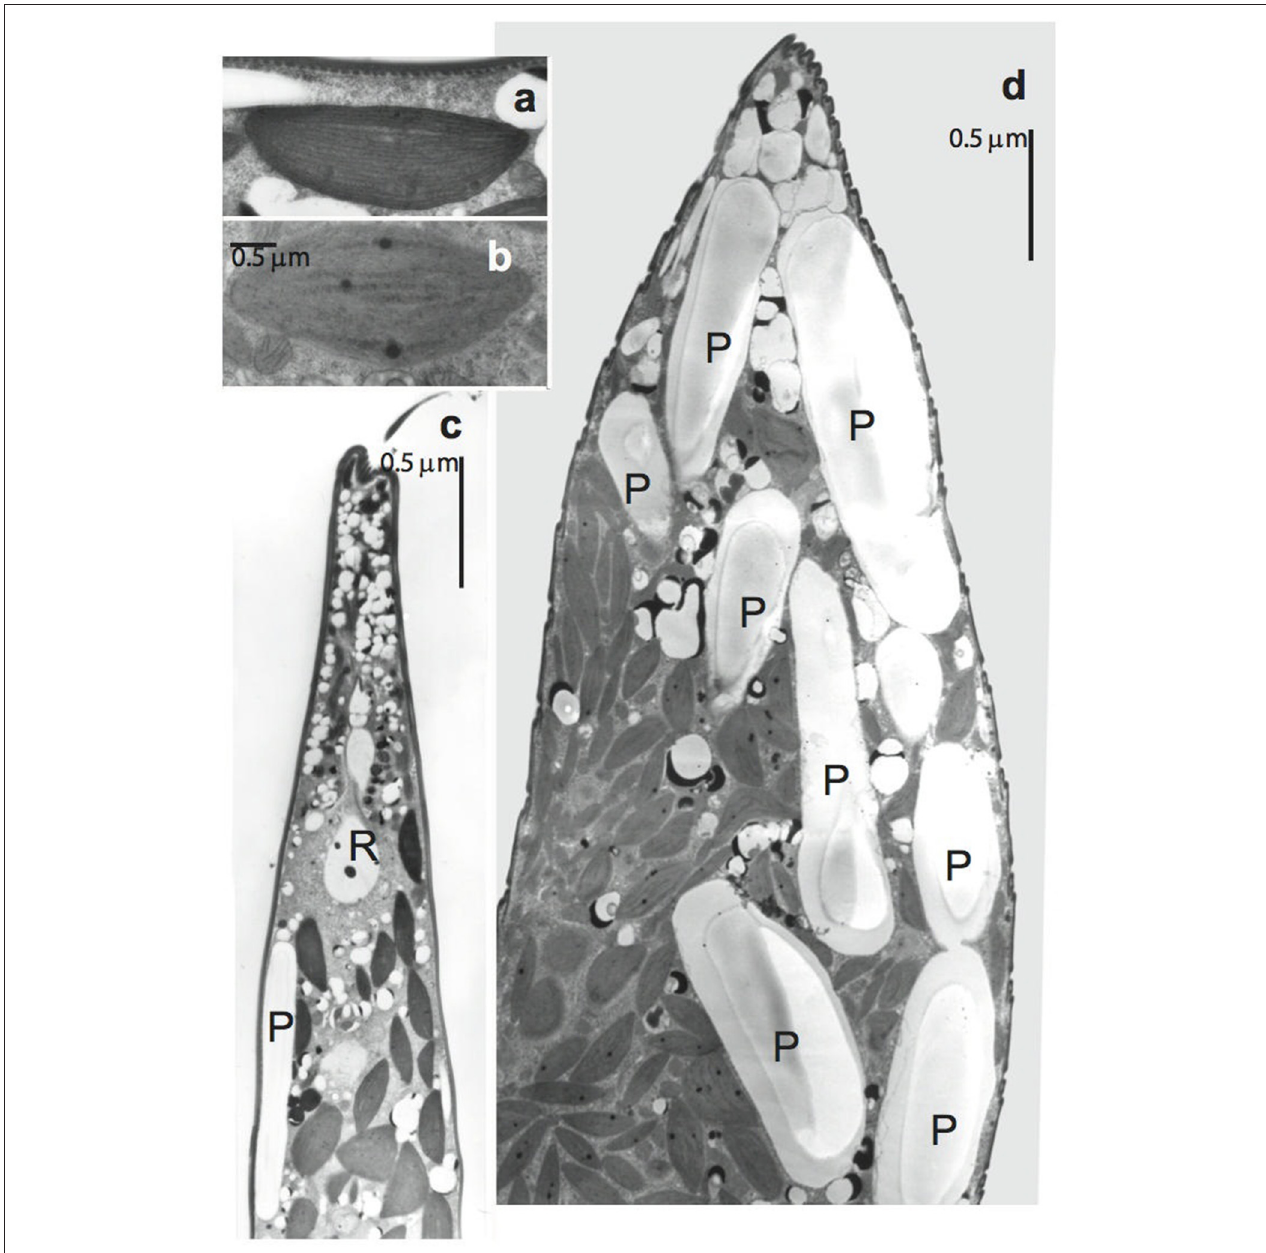
FIGURE 3 | Transmission electron micrographs of Lepocinclis acus . (a,b) Details of chloroplasts. (a) Control cell. (b) Treated cell showing the incipient thylakoid lamellae disorganization. (c) Longitudinal section through the anterior portion of control cell. Note several little spherical and few rod shape paramylon bodies (R). (d) Longitudinal section through the anterior portion of treated cell. Note numerous and extremely large paramylon grains (P).